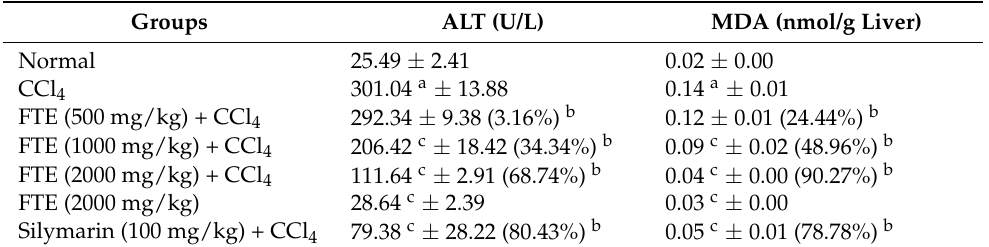
Table 3. The effect of the FTE on serum ALT and hepatic MDA in liver injury induced by CCl 4 in rats. Groups ALT (U/L) MDA (nmol/g Liver) Normal 25.49 ±